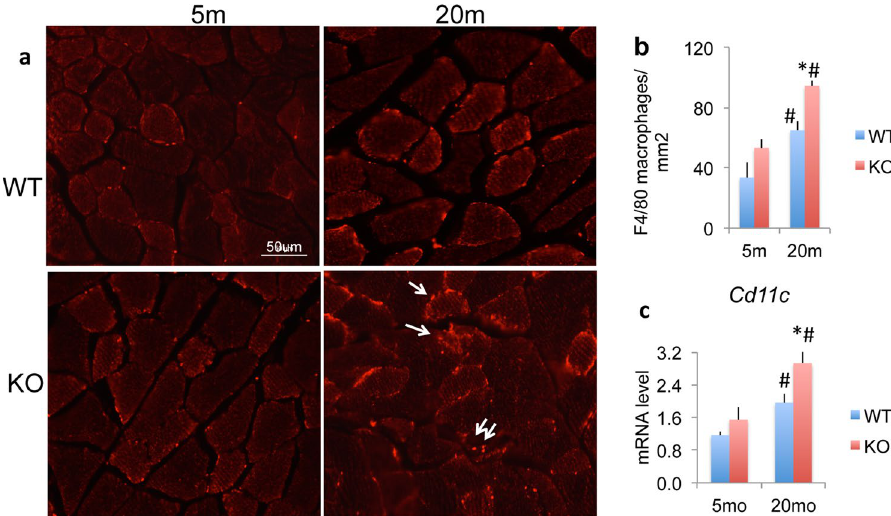
Figure 5. Expression of inflammatory cells in skeletal muscles of WT and Fgf2KO mice. Muscle sections from tibialis anterior muscle in 5 m and 20 m old WT and Fgf2KO mice were used. ( a ) F4/80 + macrophages (arrows) in the muscle of mice. Compared with young of both genotypes, there were increased F4/80 + cells in old muscle of both genotypes with a further increase in 20 m Fgf2KO. ( b ) Quantification of macrophages in the muscle showed reveals a significant increase in macrophages in 20 m WT and 20 m Fgf2KO and a further significant increase in 20 m Fgf2KO compared with 20 m WT. n = 10 fields/mouse, n = 3 mice/group. ( c ) Cd11c mRNA levels in muscle. n = 4–8 mice/group. *Compared to corresponding WT p < 0.05, # compared to corresponding 5 m p <